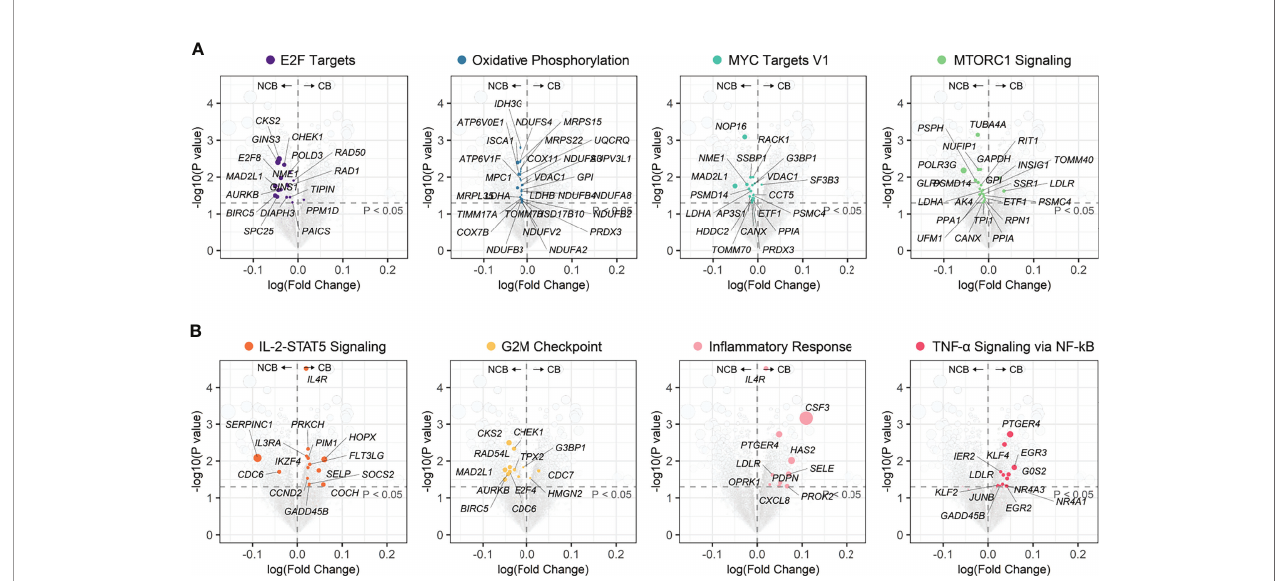
FIGURE 9 | Volcano plots of differential genes between CB group and NCB group of ccRCC in the immunotherapy cohort. (A) Position in the volcano plot of genes involved in biological pathways upregulated in the NCB group. (B) Position in the volcano plot of genes involved in biological pathways upregulated in the CB